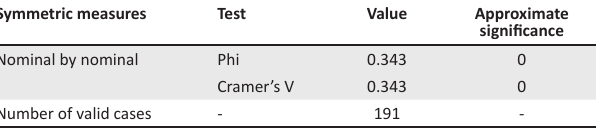
TABLE 4: Cramer’s V test: The relationship between saccadic accuracy and the learning